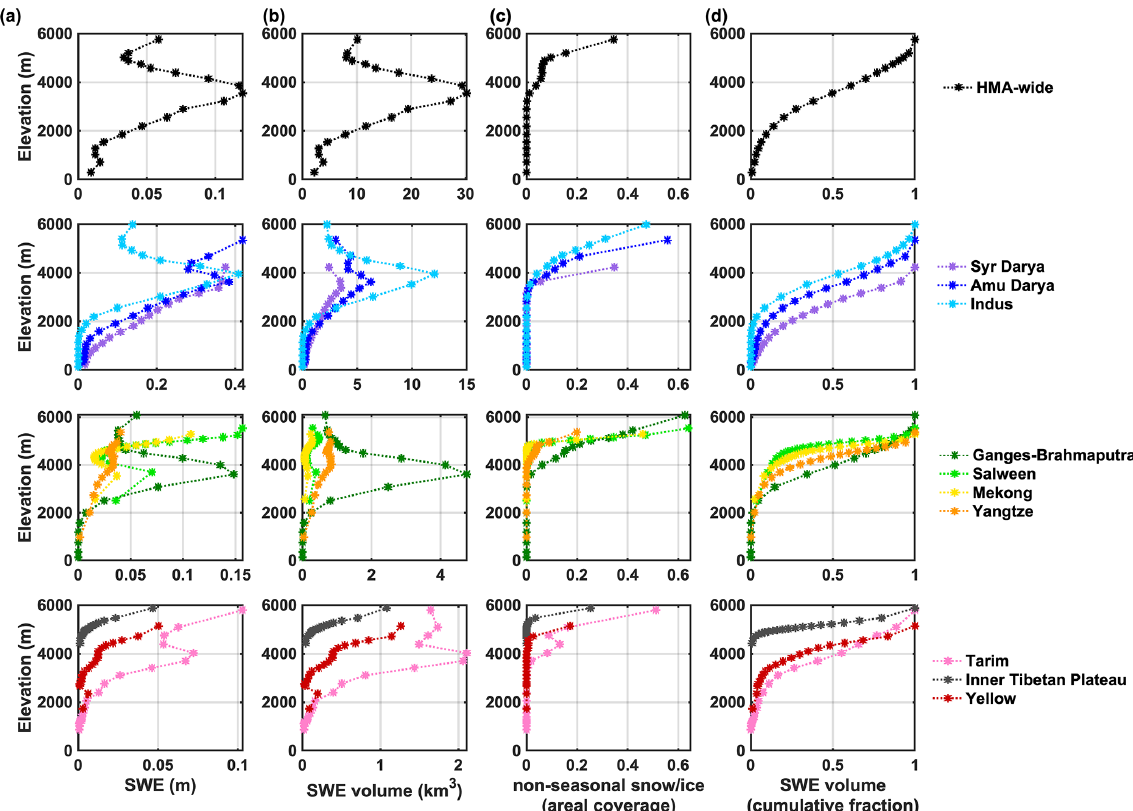
Figure 10. Pixel-wise peak seasonal (a) SWE climatology, (b) SWE volume climatology, (c) fractional areal coverage of non-seasonal snow and ice within each elevation band, and (d) cumulative fraction of SWE volume above the specified elevation, within HMA, northwest- ern (NW), southeastern (SE) and northeastern (NE) basins. Elevation is discretized into 5-percentile bins.